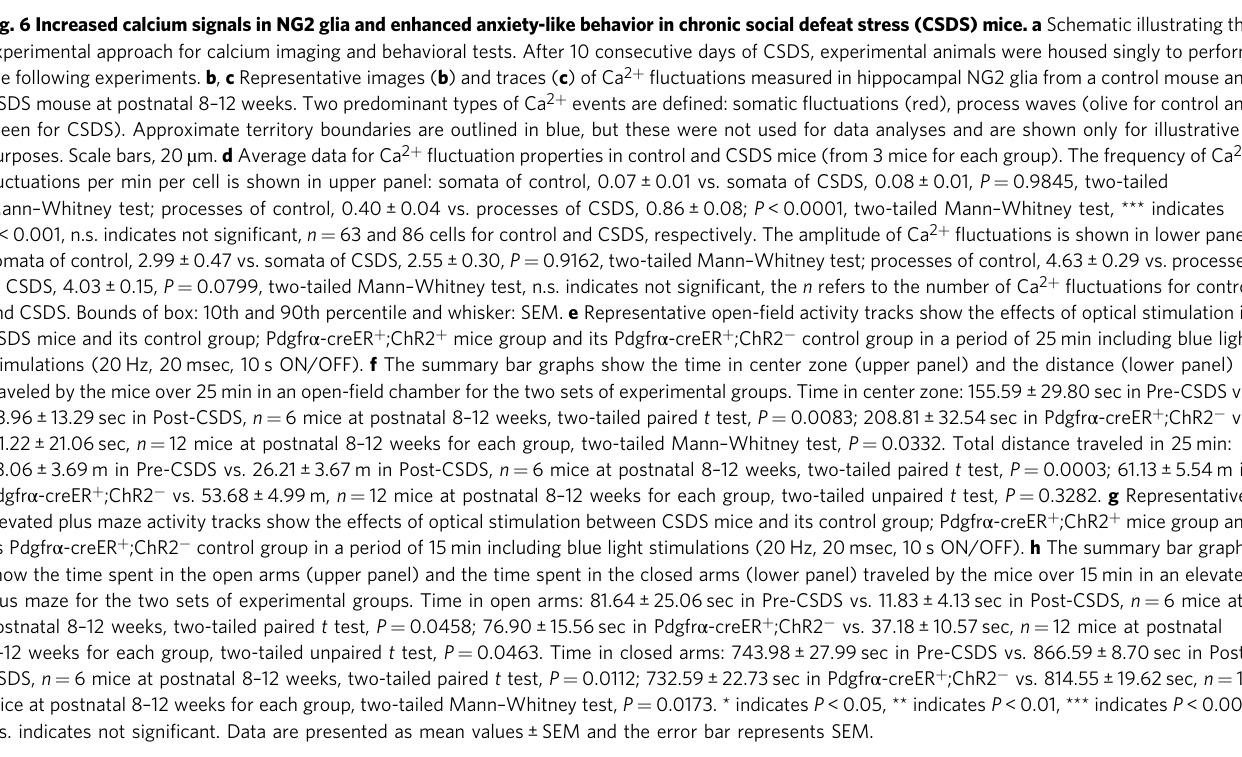
synapses of drosophila and synaptic integration of glioma and neurons 41,72 . Our fi ndings herein provide a new perspective by demonstrating that NG2 glia-to-neuron synapses exist in the mammalian brain and shed new insights into our understanding of how glial cells integrate into neural circuits and the mutual crosstalk at the synaptic level in the CNS.